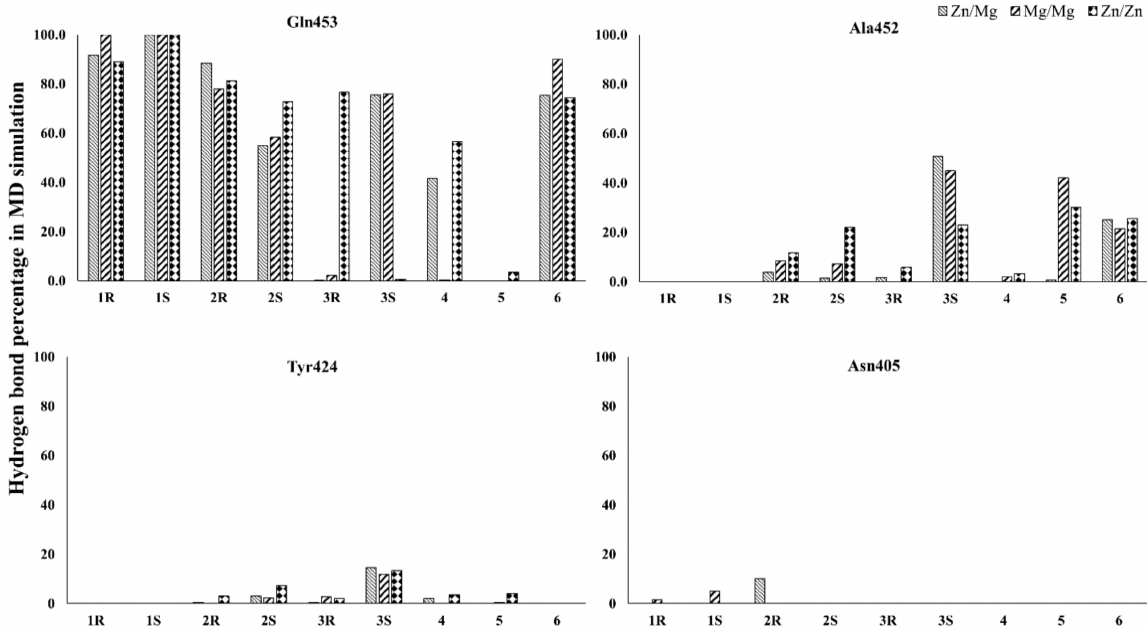
Figure 3. The strength of the hydrogen bond interactions between the critical residues of PDE-9 (in Zn/Mg, Mg/Mg, and Zn/Zn) and the compounds was monitored throughout the simulations.